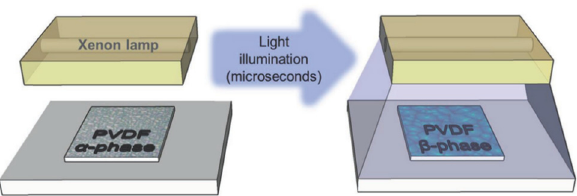
Figure 14: Schematic representation of the UV - annealing process of PVDF thin fi lms [ 127 ]